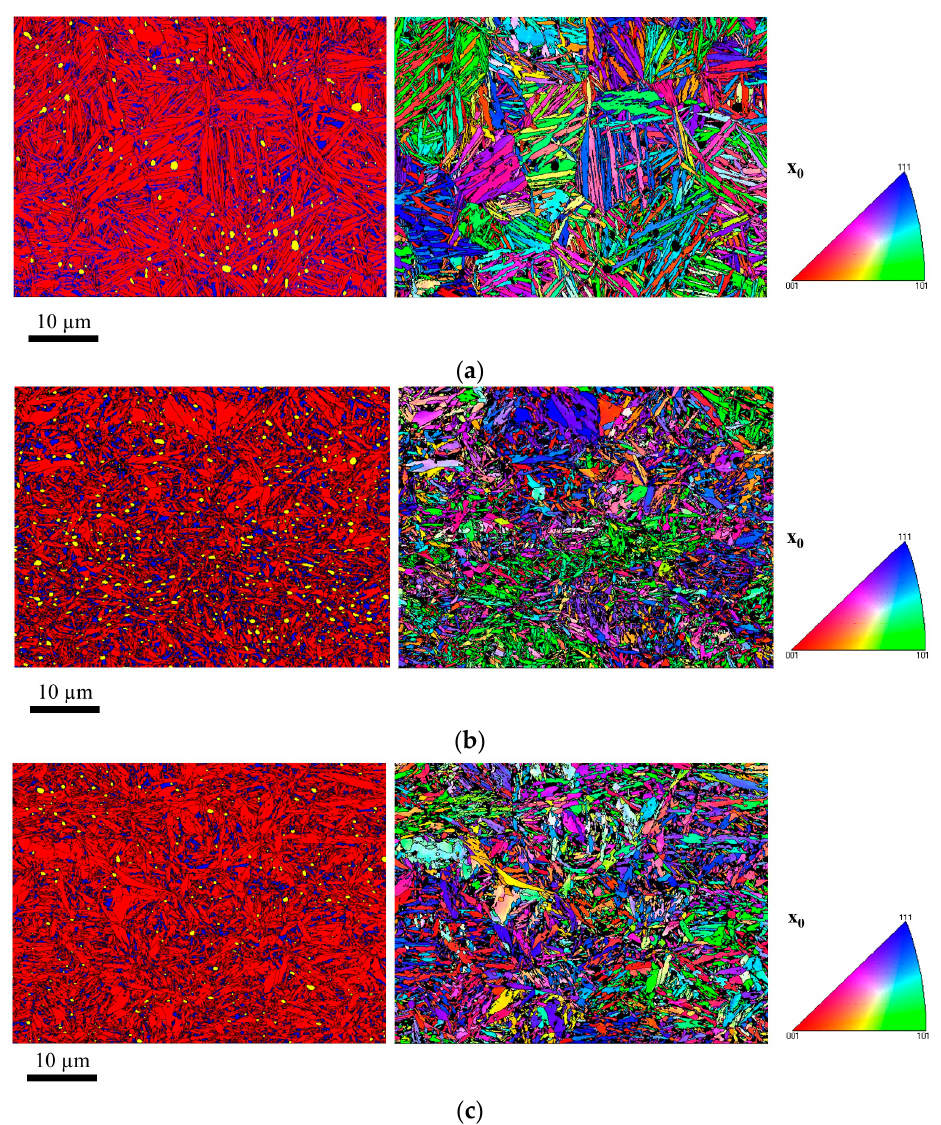
Figure 5. Electron backscatter diffraction (EBSD) phase maps with body-centered cubic (bcc) ferrite in red, face-centered cubic (fcc) ferrite in blue, and undissolved primary carbides in yellow; and corresponding bcc inverse-pole figure (IPF) maps for ( a ) bainitic structures, ( b ) Q&P, and (c) Q&T martensitic structures treated at 230 °C.